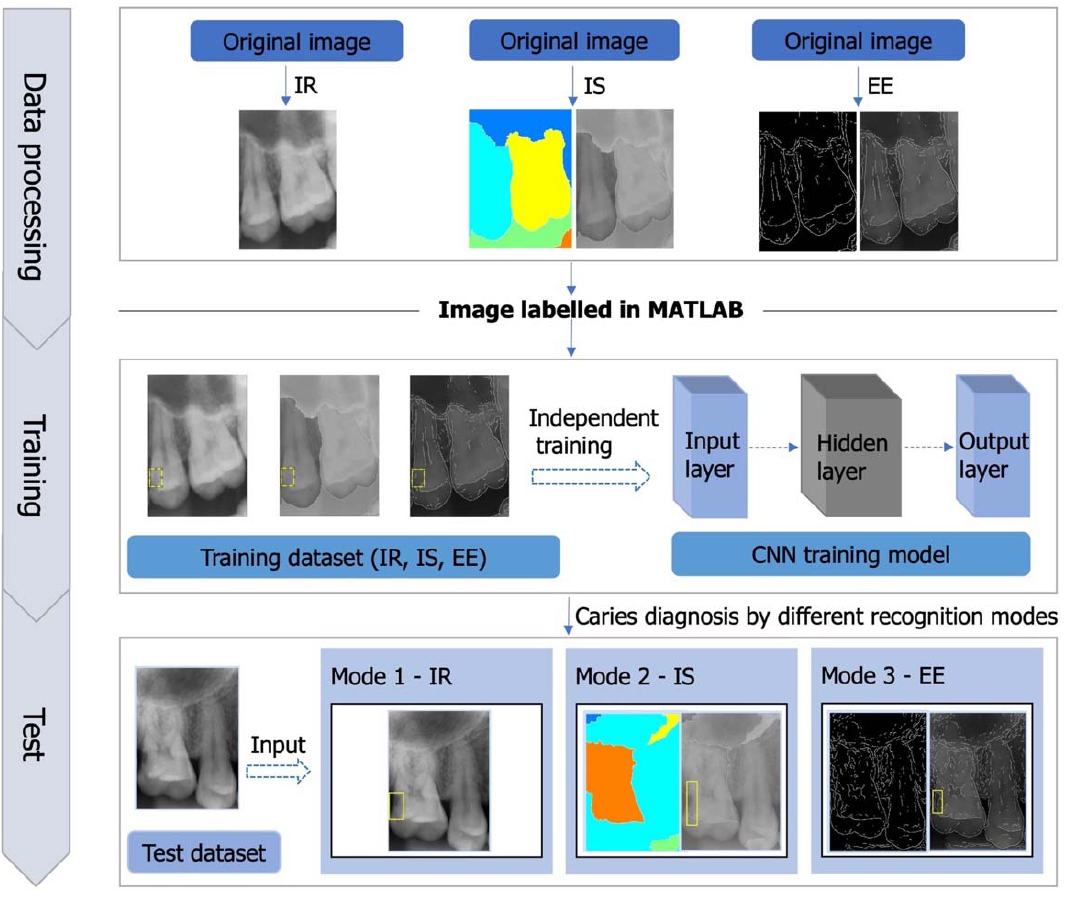
Figure 1. Proximal caries detection on periapical radiographs using deep learning with different recognition modes.